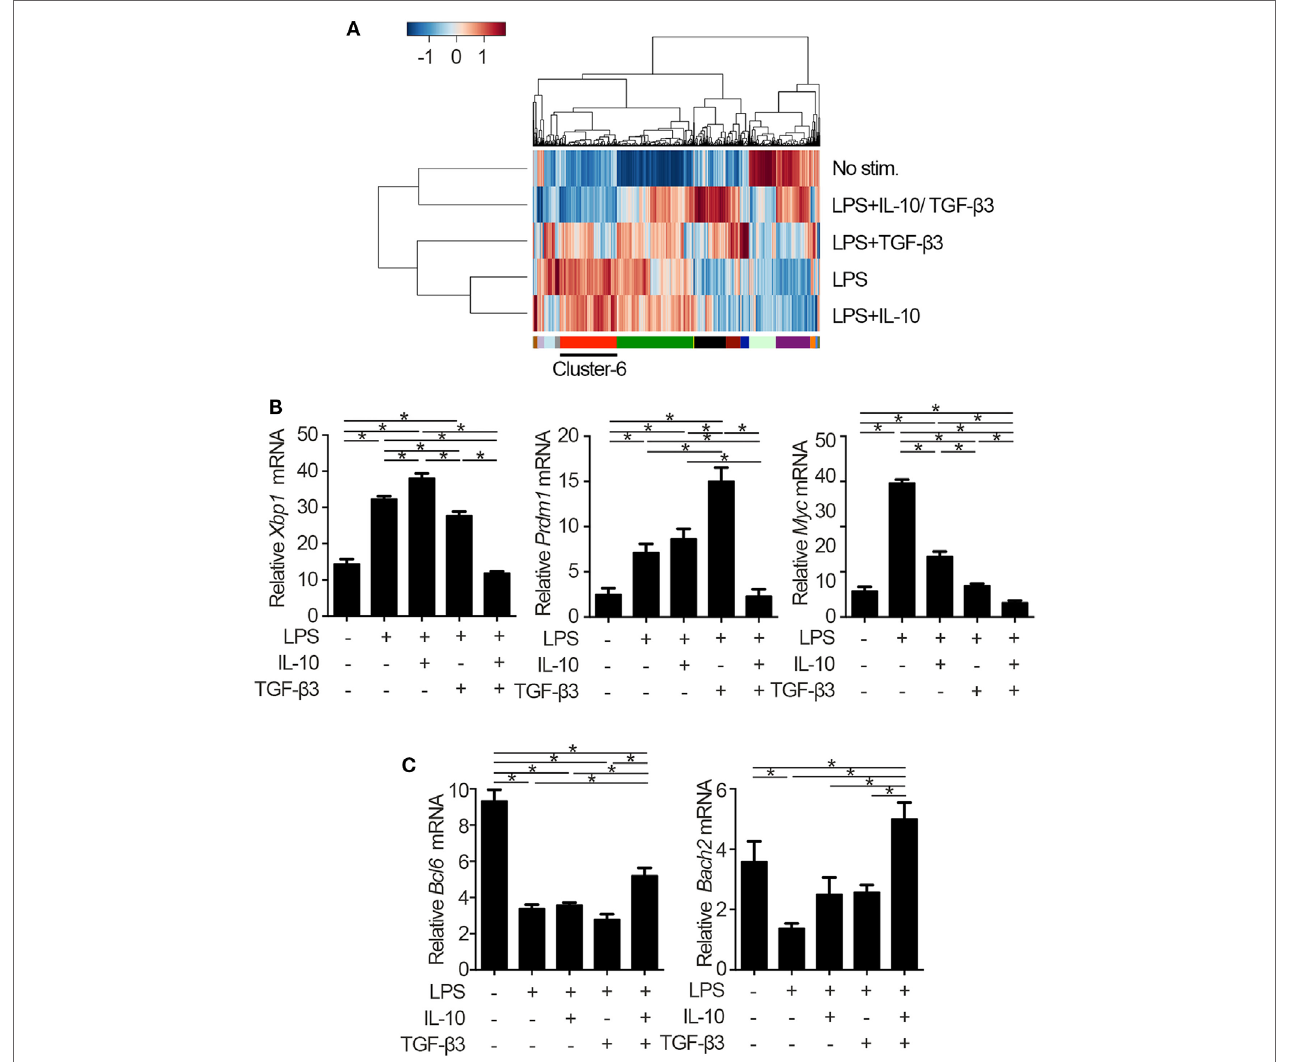
FigUre 4 | Cytokine synergy of TGF- β 3 and interleukin-10 (IL-10) modulate transcriptional programs in lipopolysaccharide (LPS)-stimulated B cells. (a) Heatmap visualization and hierarchical clustering analysis of differentially expressed genes of whole genome RNA-sequencing from B220 + 7-AAD − B cells stimulated by LPS with either TGF- β 3 and/or IL-10 for 3 days. The clustered genes were subdivided into 16 categories labeled by different colors. (B,c) qRT-PCR analysis of genes downregulated (B) or upregulated (c) with TGF- β 3 and IL-10 more than those in LPS-stimulated B cells ( n = 3). P < 0.05 by one-way analysis of variance followed by Bonferroni’s multiple comparisons test (B,c) . Error bars,